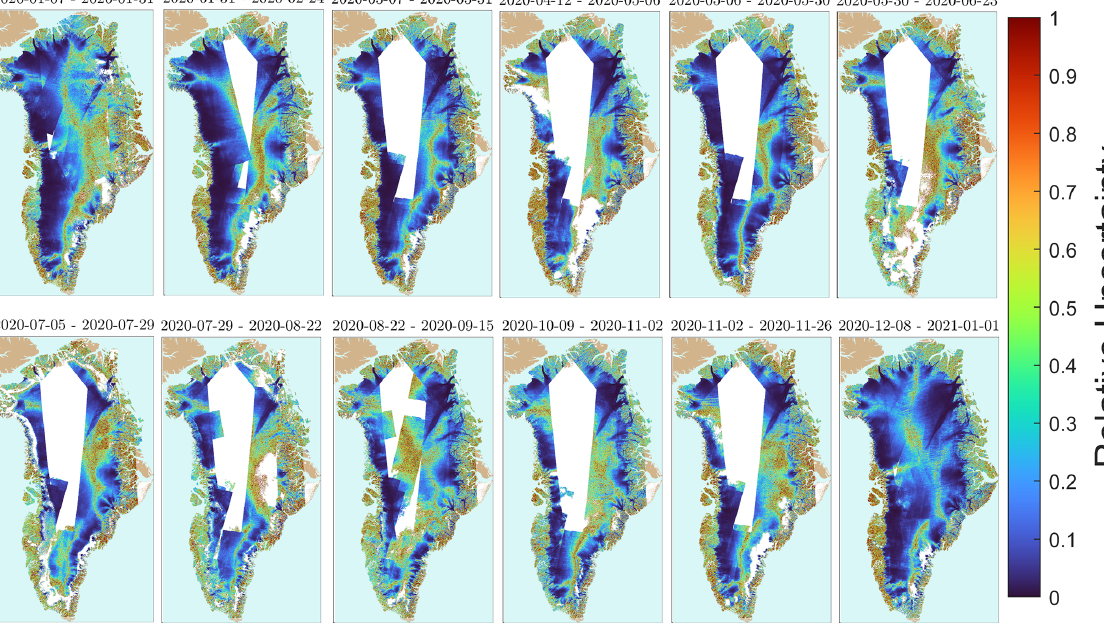
Figure 9. Greenland-wide view of the error estimates for the PROMICE mosaics displayed in Fig.